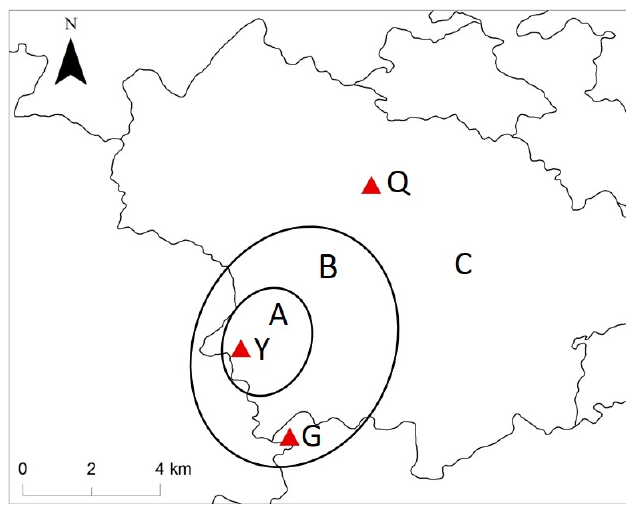
Fig. 1: Classification of rock tea region and the selected tea plantations. A – authentic rock region; B – semi-authentic rock region; C –